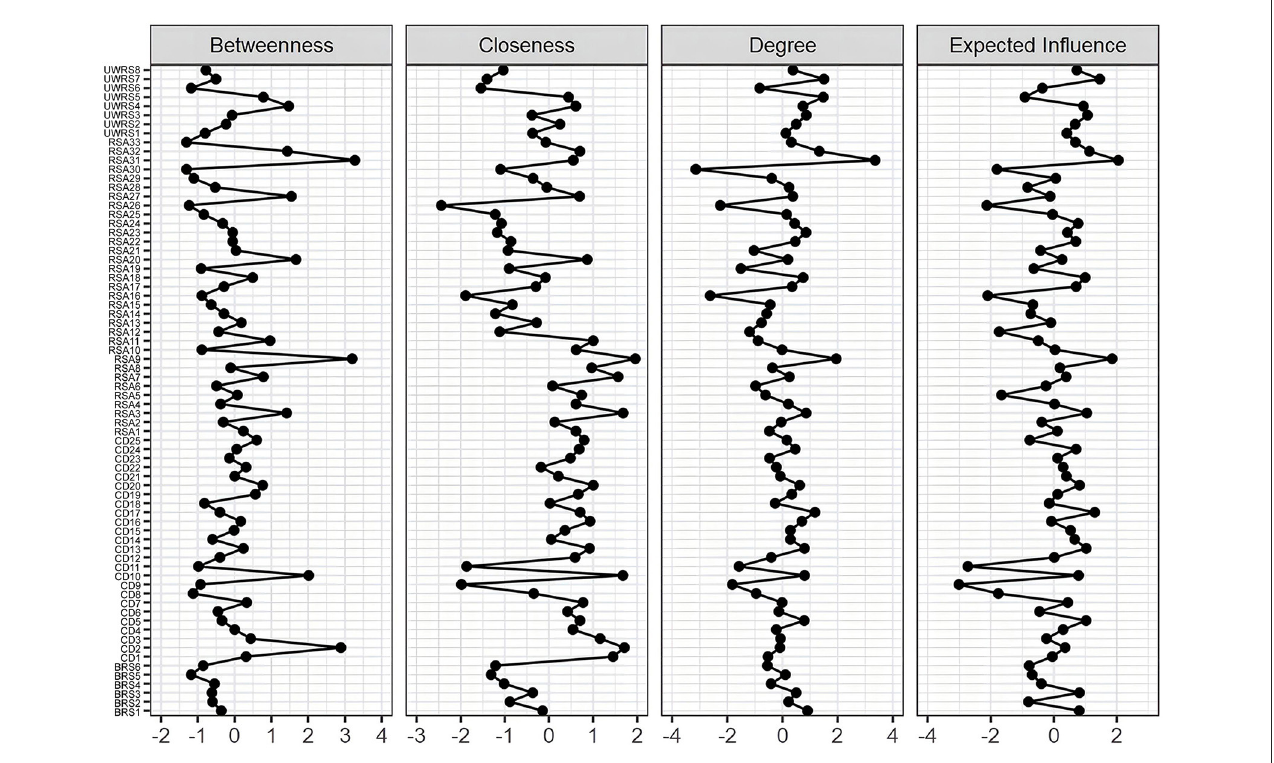
FIGURE4 Centrality network analysis of CD-RISC, UWRS-8, BRS, and